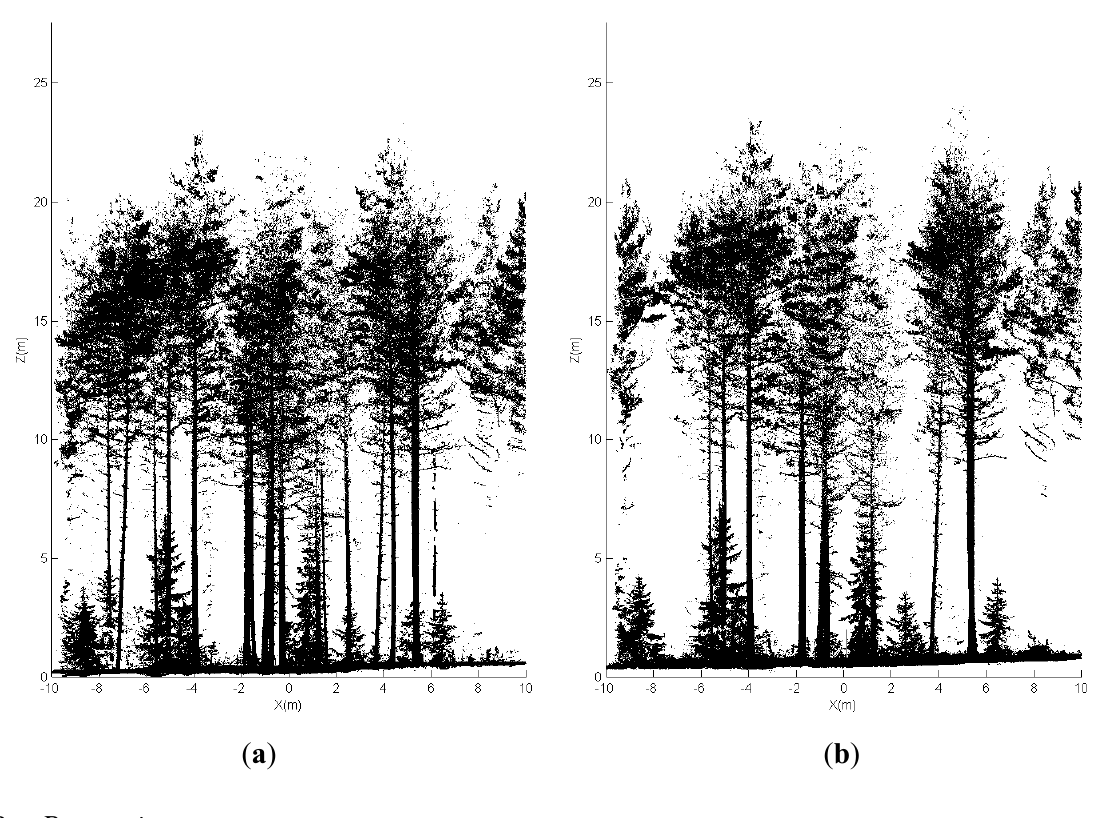
Figure 2. The terrestrial laser scanning (TLS) data for the plot ( a ) before and ( b ) after the harvest